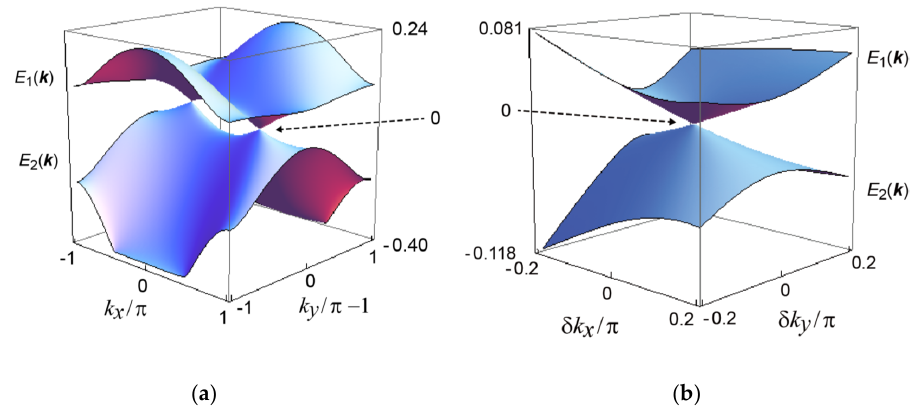
Figure 2. Calculated band structure around the Dirac points of α -STF 2 I 3 [37]: ( a ) Energy dispersion (eV) of the two bands closest to the Fermi energy, E 1 ( k ) and E 2 ( k ), as functions of k = ( k x , k y ), where ( x , y ) corresponds to ( b , a ). The energy at the Dirac points is equal to the chemical potential, which is defined to be the origin of energy; ( b ) Enlarged view at one of the Dirac points, which are located at k D = ( k x / π , ( k / π ) − 1) = ± (0.61, − 0.18) and are indicated as broken arrows with naughts (0 eV). δ k = k − k D .